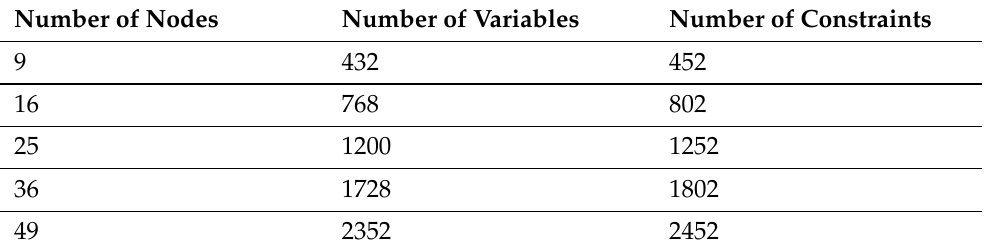
Table 5. Problem sizes for algorithm using total energy consumption index, for algorithm using maximal energy consumption index number of variables and the number of constraints must